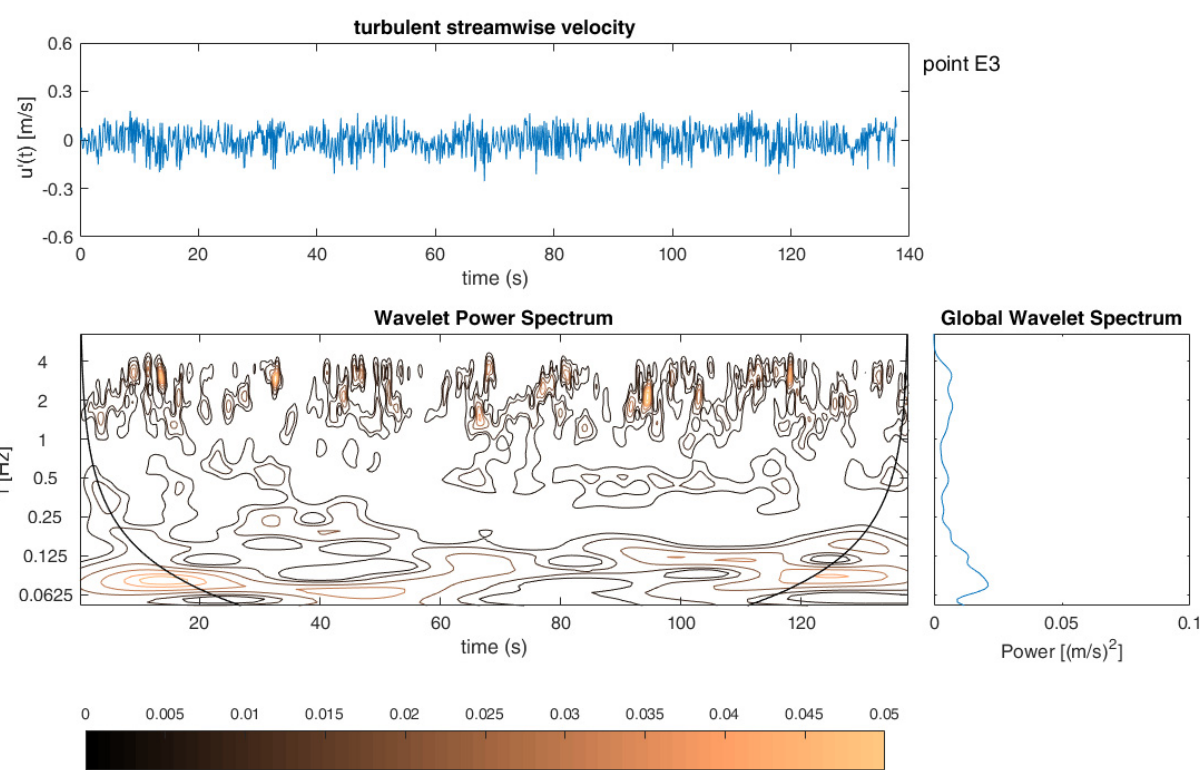
Figure 8. W1 wave: signal of the turbulent streamwise velocity u’ ( t ), spectrogram of u’ ( t ), and global wavelet spectrum for the selected point E3.